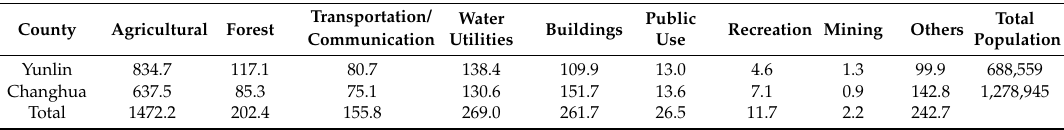
Table 3. Existing land use inventory (area in km 2 ) and population (as of July 2017) for the Changhua and Yunlin